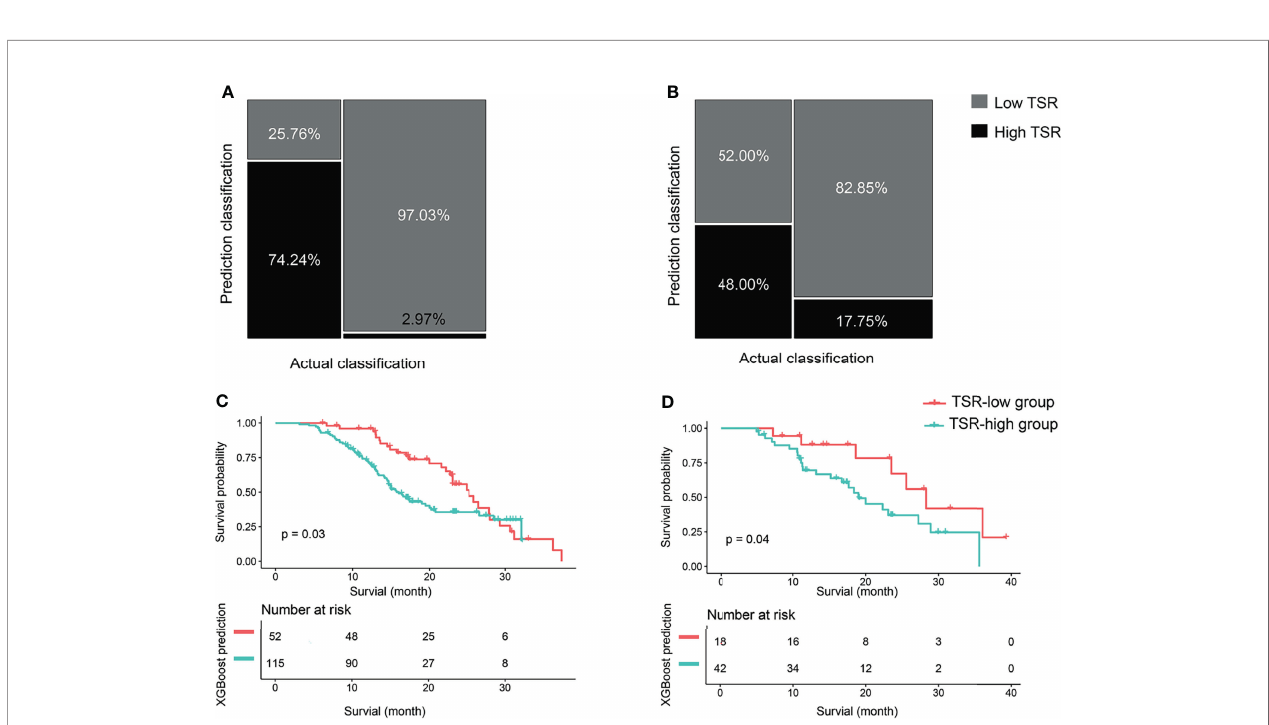
FIGURE 6 | The classi fi cation and survival prediction of the extreme gradient boosting (XGBoost) classi fi er. (A) Mosaic plot of the training set. (B) Mosaic plot of the validation set. (C) The survival prediction of the XGBoost classi fi er shows signi fi cantly longer survival for patients in the tumor – stroma ratio (TSR)-low group than those in the TSR-high group in the training set. (D) The survival prediction of the XGBoost classi fi er reveals signi fi cantly longer survival for patients in the tumor – stroma ratio (TSR)-low group than those in the TSR-high group in the validation set.